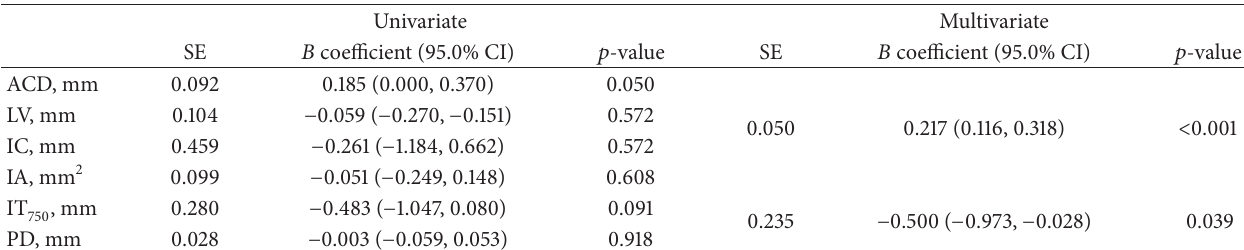
) assessed post-LPI in the BG (AOD 750